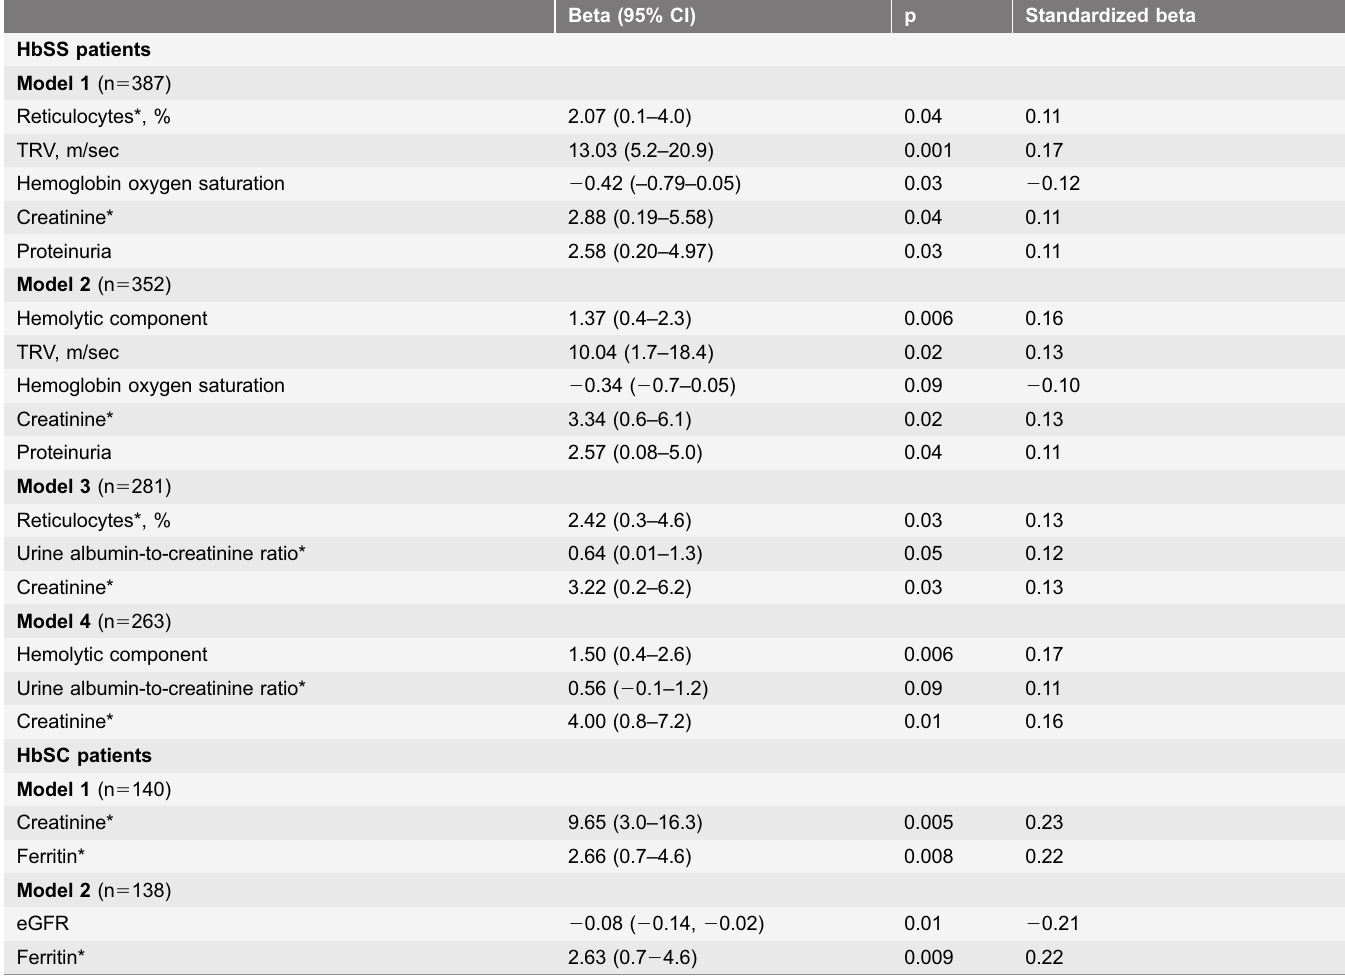
Table 3. Independent predictors of pulse